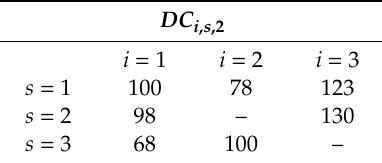
Table A12. Maximum distribution capacity at time period 2 (units).